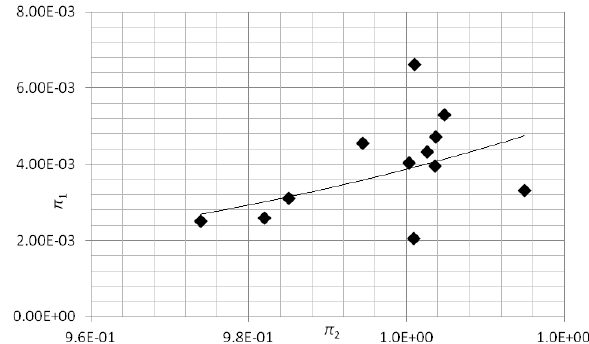
Fig. 2. Non-dimensional arguments and regression line for nitrogen concentrations. Figure 2. Non-dimensional arguments and regression line for nitrogen concentrations. 3